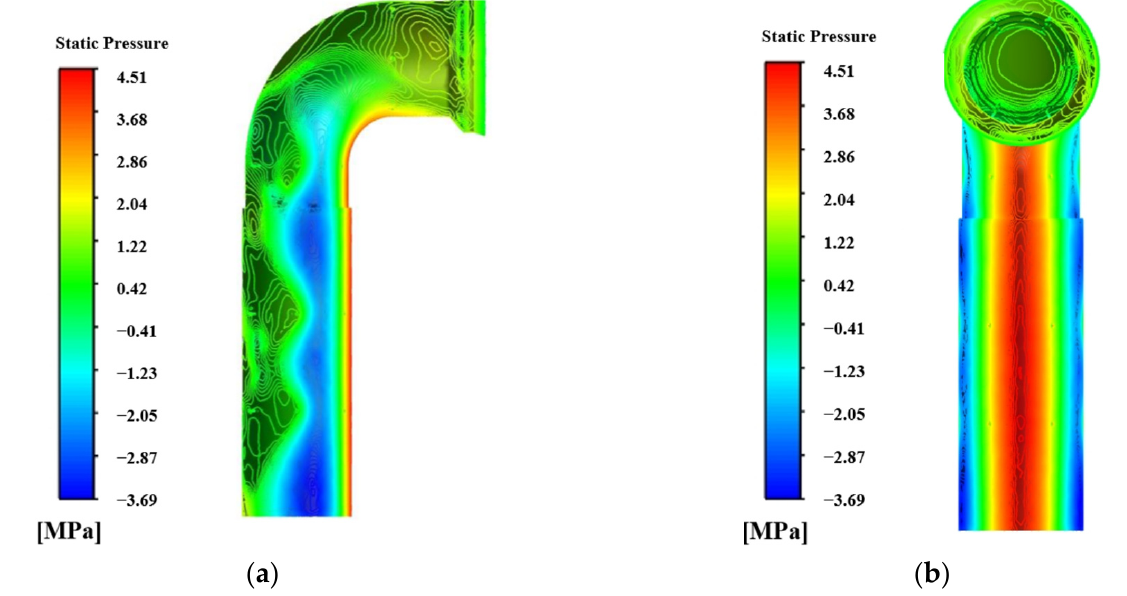
Figure 10. Examples of the test findings for seawater erosion: ( a ) YZ plane pressure cloud; ( b ) XY plane pressure cloud.